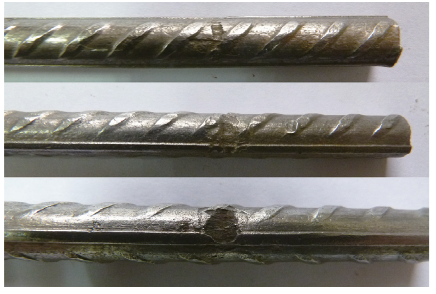
Figure 6: The picture of pitting